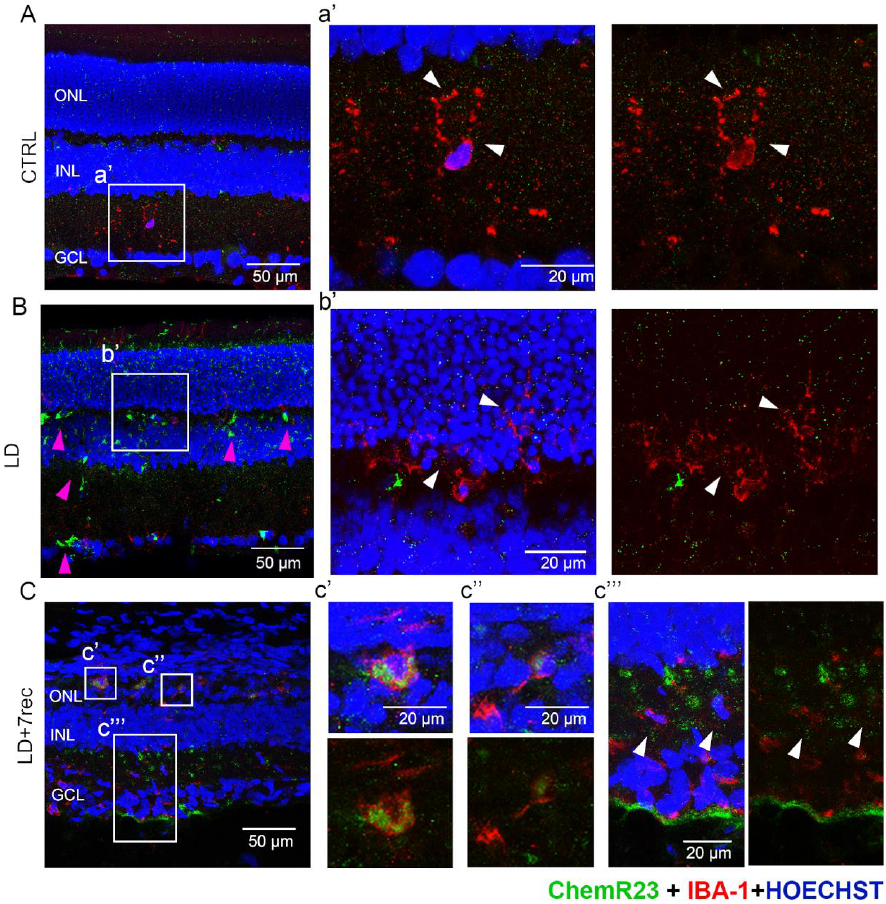
Figure 4. Double immunostaining for IBA-1 and ChemR23. ( A – C ) Confocal images of retinal cryosections labelled for IBA-1 (red) and ChemR23 (green), and counterstained with bisbenzimide nuclear dye (blue) of ( A ) CTRL, ( B ) LD and ( C ) LD + 7rec retinas. Scale bar: 50 µm. High magnifications ( a’ , b’ , c’ , c” , c”’ ), scale bar 20 µ m. The white arrows show detailed localization of ChemR23 in IBA-1 (+) cells. The pink arrows indicate increased ChemR23 signal in the LD group not co-localizing with IBA-1 (+) cells. CTRL (Control); LD (Light damage); LD + 7rec (Light damage + 7 days of recovery); ONL (Outer nuclear layer); INL (Inner nuclear layer); GCL (Ganglion cell layer).